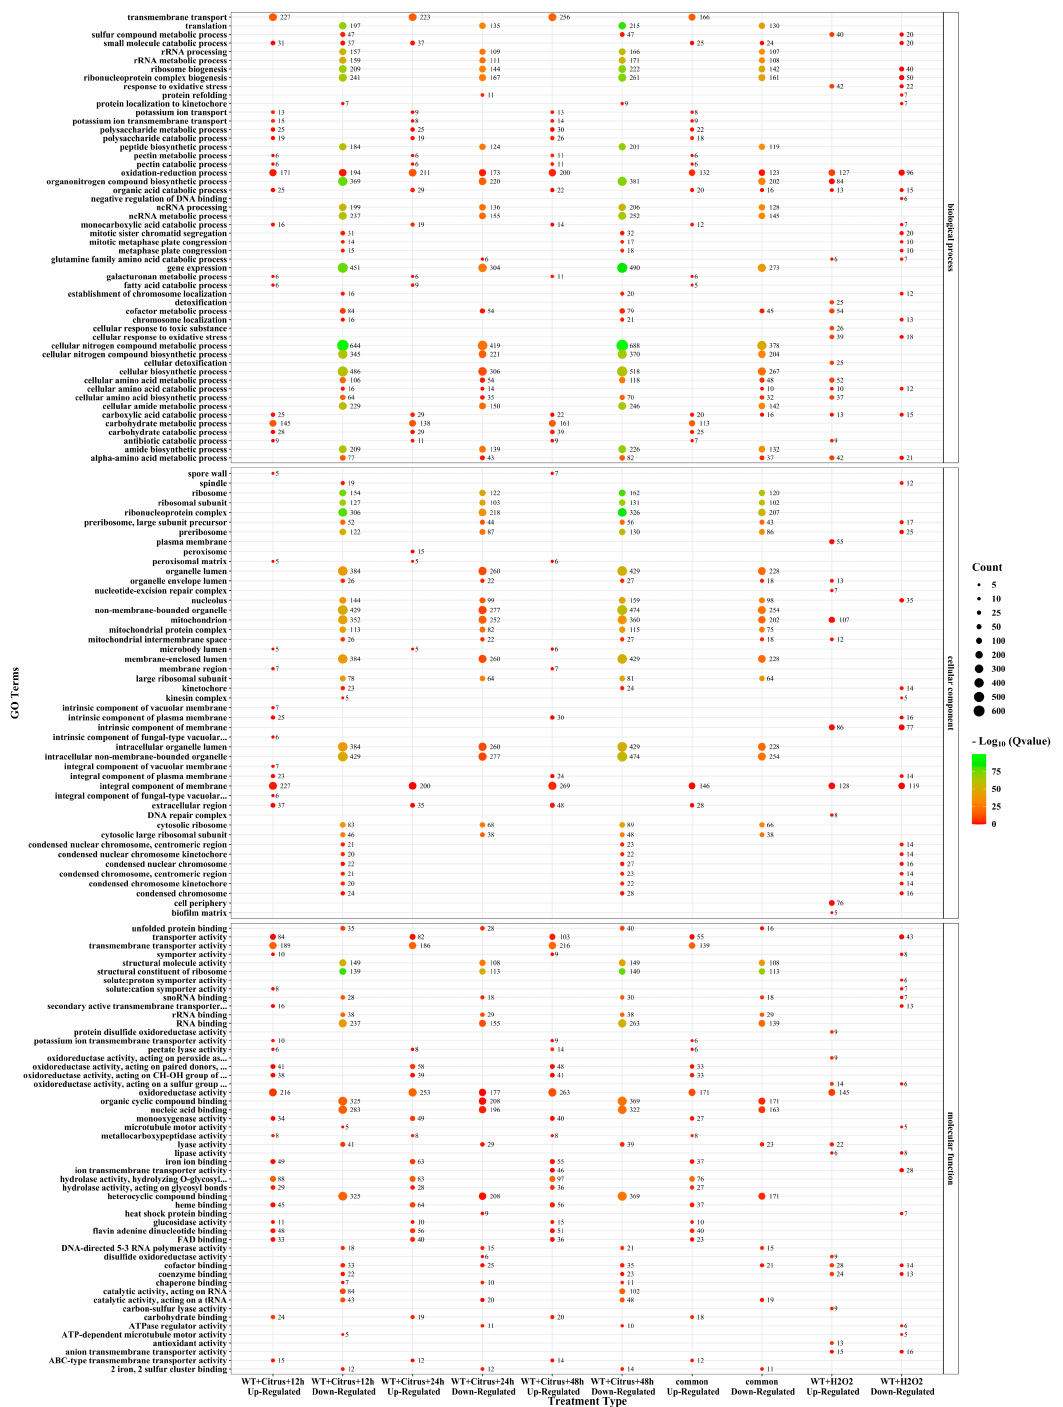
Figure 5. Comparative Gene Ontology (GO) analysis was conducted on the differentially expressed genes (DEGs) between the transcriptome of Alternaria alternata and A. alternata inoculated on citrus leaves for 12-, 24-, and 48 h, common (differentially expressed genes that are commonly up-regulated or down-regulated in the three infection stages) and A. alternata under oxidative stress (WT + H 2 O 2 ). The results were organized into three main GO categories (biological processes, cellular components, and molecular functions), with the count representing the number of DEGs annotated in each GO category. The x-axis indicated the different mutants, while the y-axis indicated the GO term. The color was used to denote the -log10(q value) of each GO